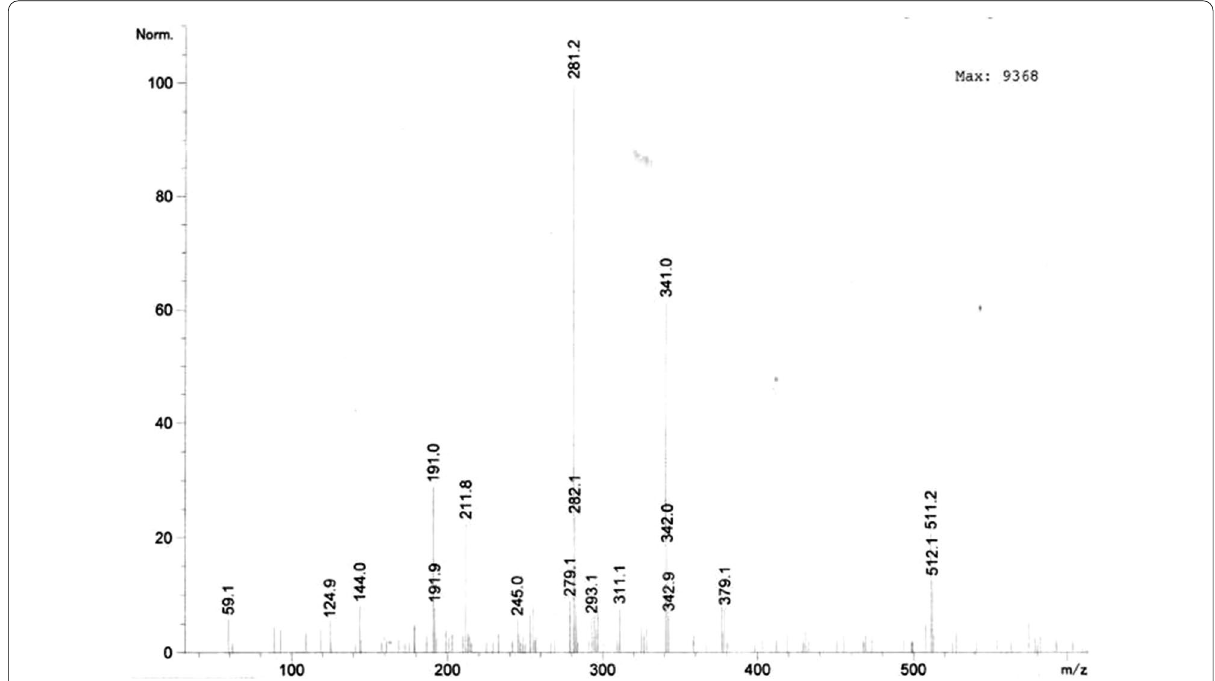
Fig. 1 Liquid chromatography mass spectrometry (LC–MS) analysis of guava leaf